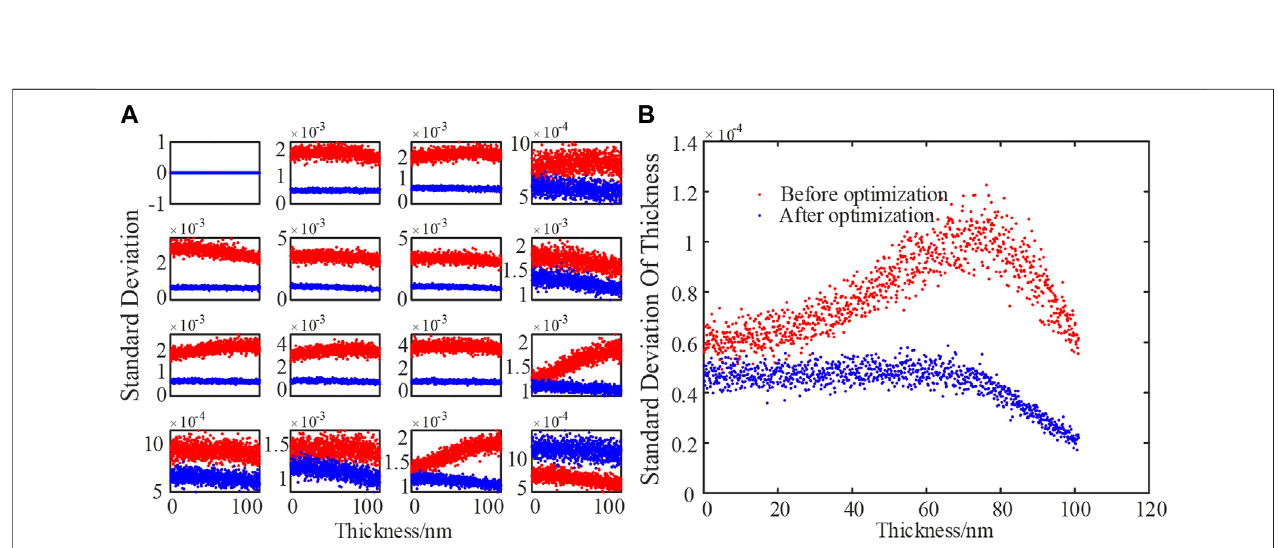
FIGURE 12 | Simulation results for Poisson shot noise (A) estimated standard deviation of Mueller matrix elements for the samples with different thicknesses and (B) thickness-dependent standard deviation of the measured thickness.